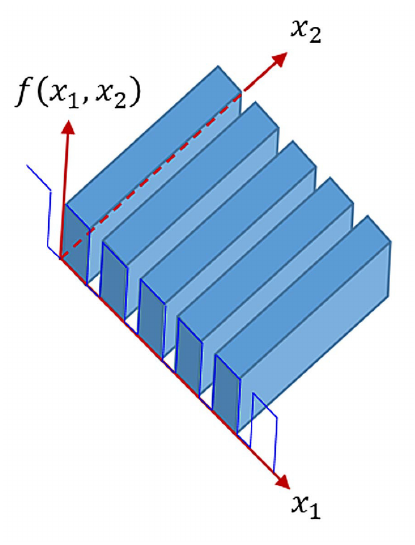
Figure 5. Extension of 1D rectangular wave function f ( x 1 ) along x 2 axis into 2D grid